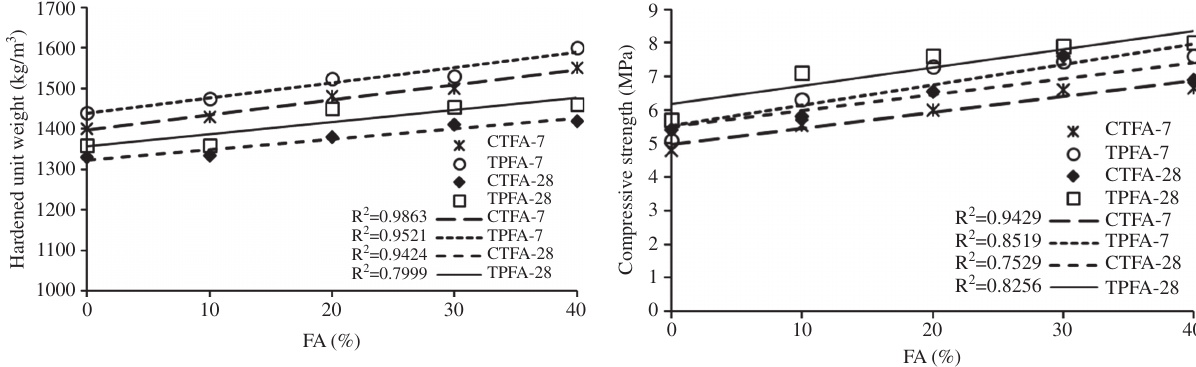
Figure 2 Hardened unit weight of specimens.